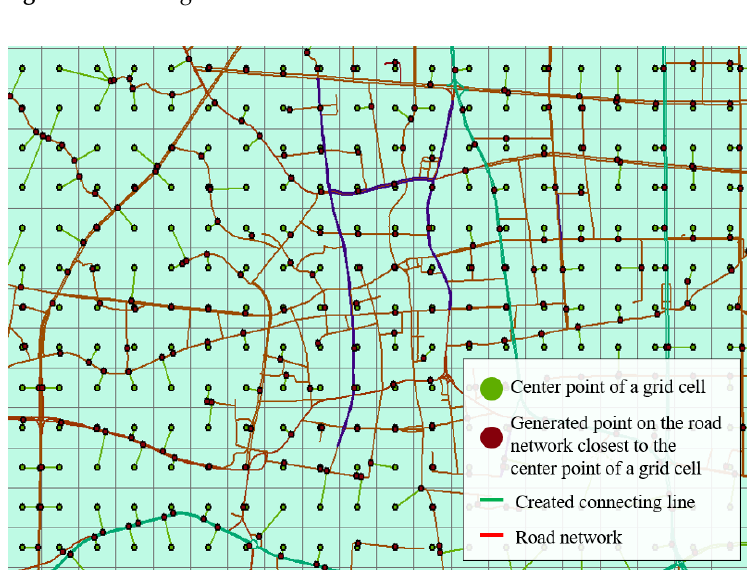
Figure 7. Details of Zhicheng’s road network model.